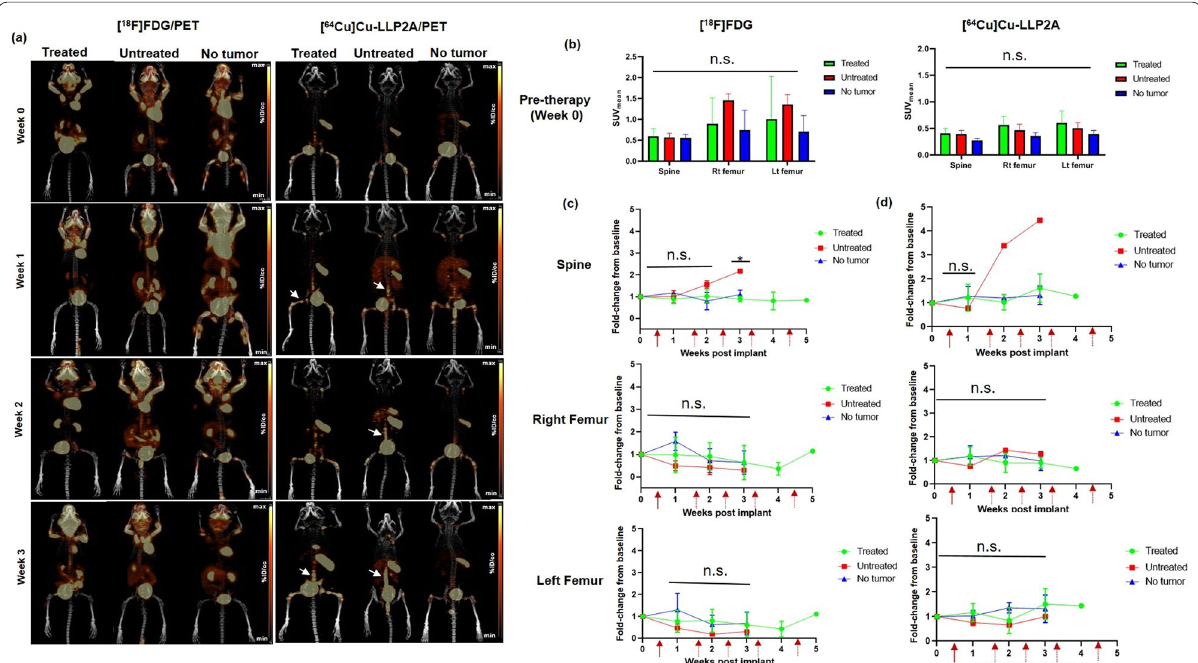
Fig. 4 a Representative small animal maximum intensity projection (MIP) [ 18 F]FDG and [ 64 Cu]Cu-LLP2A PET images in disseminated U266-CG tumor mice (treated and untreated) as well as in no tumor mouse cohorts, respectively. Bortezomib therapy was started in the treatment cohort between weeks 0–1. White arrows are pointing to the selected focal tumor lesions in the treated and untreated mice imaged with [ 64 Cu]Cu-LLP2A/ PET. Scale Bar ([ 18 F]FDG): Min 4% ID/cc, Max 8% ID/cc; Scale Bar ([ 64 Cu]Cu-LLP2A): Min 3% ID/cc, Max 6% ID/cc. b [ 18 F]FDG and [ 64 Cu]Cu-LLP2A PET quantification (SUV mean ) of the bone marrow rich organs—spine, right (Rt) femur and left (Lt) femur, in U266-CG disseminated tumor model and no tumor mice at week 0 (baseline, before therapy was started). c [ 18 F]FDG SUV fold-change from baseline in the spine, right (Rt) femur and left (Lt) femur in U266-CG tumor (treated and untreated) mice and no tumor mice, plotted as a function of time. d [ 64 Cu]Cu-LLP2A SUV fold-change from baseline in the spine, right (Rt) femur and left (Lt) femur in U266-CG tumor mice (treated and untreated) and no tumor mice, plotted as a function of time. * p 0.05, ** p ≤ ≤